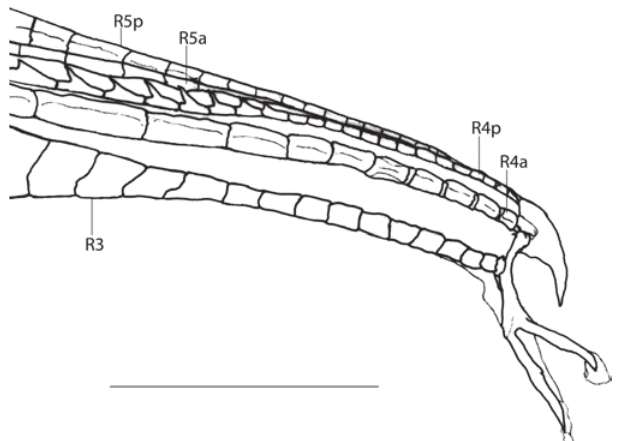
MCP 20158. R3, R4a, R4p, R5a, R5p indicate gonopodial rays. Scale bar 1 mm.